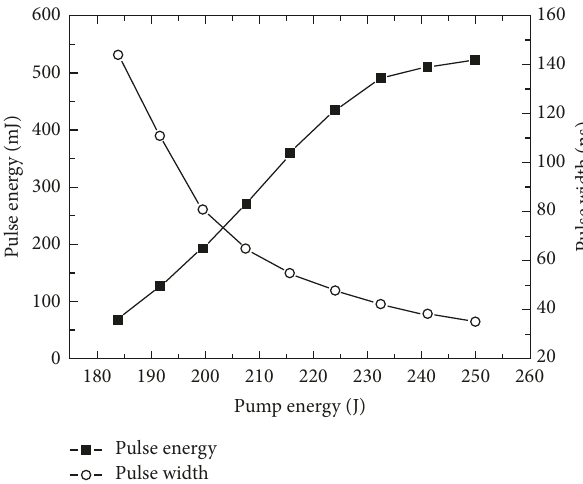
Figure 5: Output energy and pulse width as a function of the pump energy in LGS EO Q-switched Cr,Tm,Ho:YAG laser. Reprinted with permission from [19]. Copyright 2012 Optical Society of